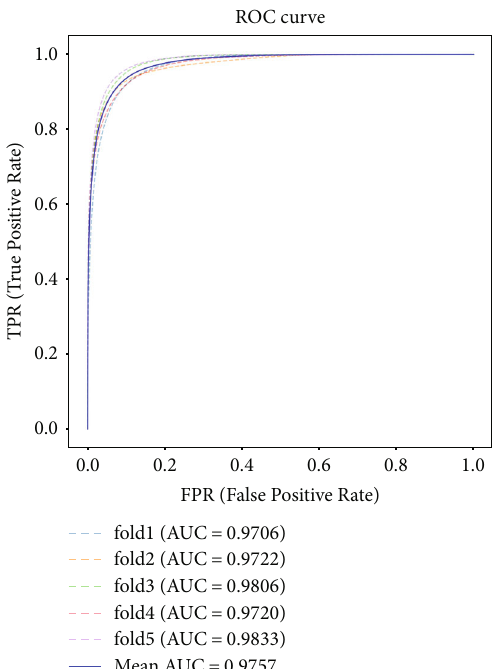
Figure 4: The ROC curves of the 5-fold crossvalidation experiments. The x -axis represented the false-positive rate, i.e., 1- speci fi city, and the y -axis represented the true-positive rate, i.e., sensitivity. The area under the curves (AUCs) were calculated, which were presented on the bottom right of the fi gure. The mean ROC curve, which was plotted with a solid line, and its AUC (namely, mean AUC) were also presented.